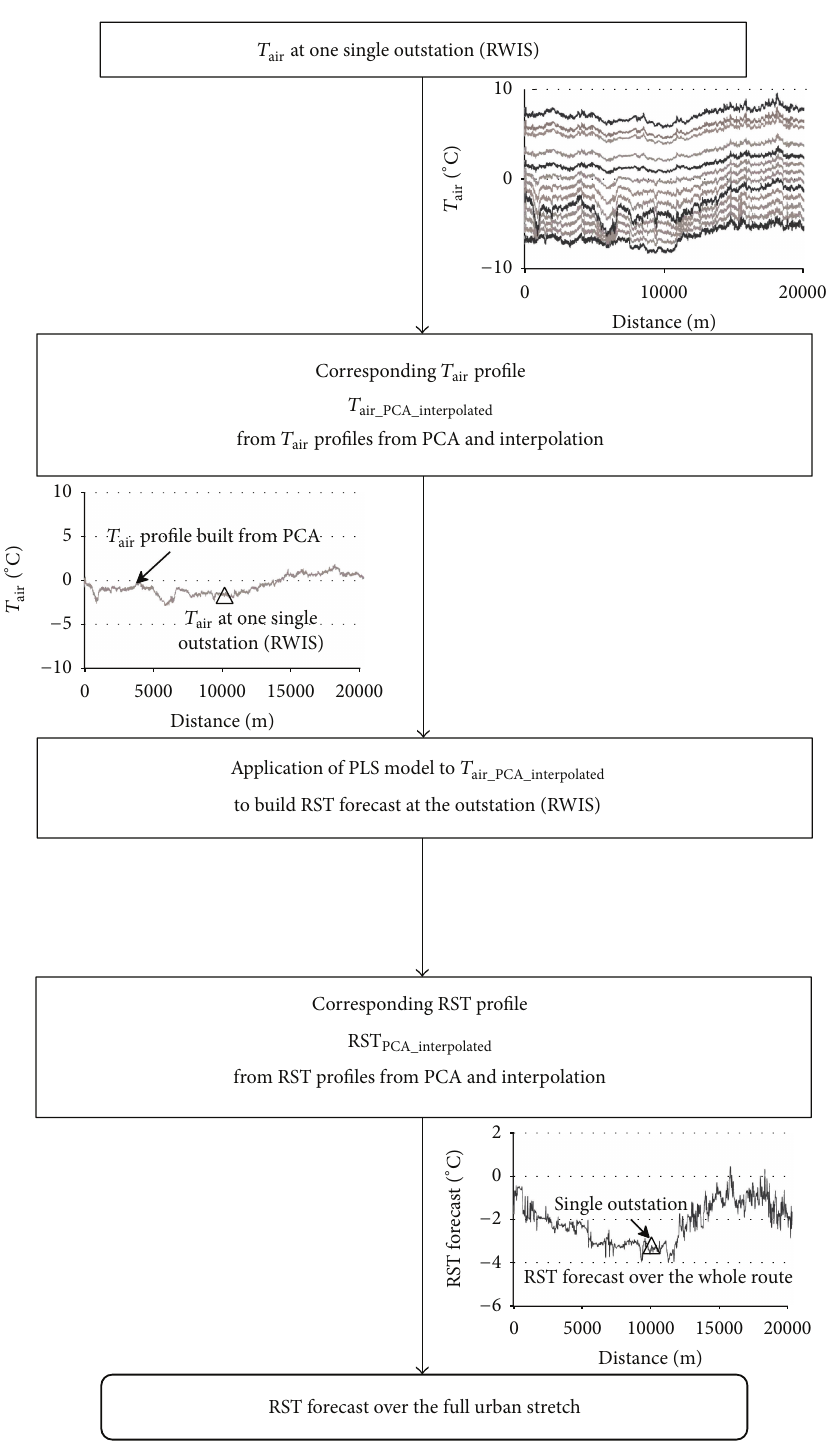
Figure 3: Description of the principle to forecast RST from 𝑇 air with PCA and